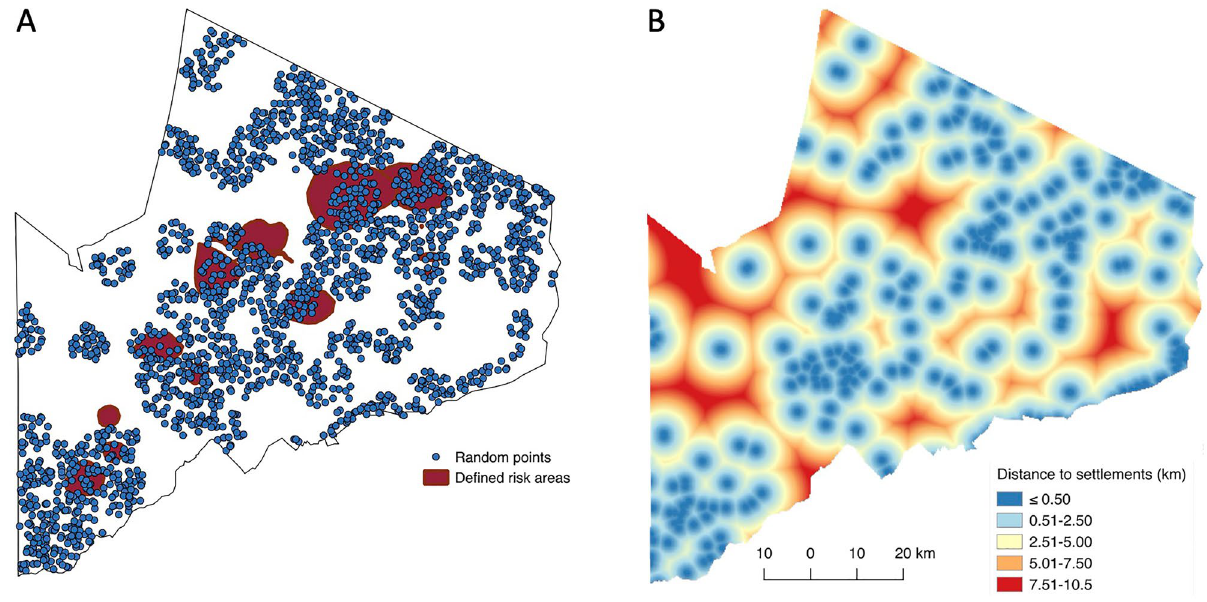
Figure 3. Ngorongoro Conservation Area map showing ( A ) defined risk areas (in red) and ( B ) distance to settlements. For analysis, 5000 random points were generated throughout the area; points falling within 4.26 km of human settlements (the average distance herds are moved from settlements in a day as determined through interviews of resident livestock owners) were retained for analysis (n = 2173, shown in blue in 3a). The maps were created in QGIS 2.18.2 using data from the National Bureau of Statistics, Tanzania (http:// www. nbs. go. of a water source to a risk area may increase the chance of infection, particularly during periods of high precipi- tation which might unearth buried spores. Average enhanced vegetation index (EVI). Vegetation density may influence the likelihood of an animal ingest- ing soil or inhaling dust that may be contaminated with spores. Grazing animals are more likely to encounter bacteria in soil with low vegetation density 20 , although there is a possibility that spores can be washed onto higher vegetation by the action of water 19 . Vegetation index may also reflect the moisture content of soil. Arid/ dry conditions favour the formation and resistance of spores in the environment, thus lower vegetation may be associated with the occurrence of anthrax. Average daytime land surface temperature (LSTD). Anthrax has been more commonly reported to occur in regions with warmer climates worldwide. Minett observed that under generally favourable conditions and at 32 °C to 37 °C, sporulation of B. anthracis occurs readily but vegetative cells are more likely to disintegrate at temperatures below 21 °C 30 . Another hypothesis for the association of high temperature with anthrax occur- rence is altered host immune response to disease due to stress caused by elevated temperatures 19 . In addition, elevated temperatures are usually associated with arid areas where vegetation is low, limiting access to adequate nutrition, which in turn affects immunity. Similarly, in hotter climates where infectious diseases occur more often, host interactions with other pathogens may modulate immune response to anthrax 31 . In this case, a lower infectious and lethal dose of spores would be sufficient to cause infection and death, respectively 19 . Contact with and ingestion of soil, spores and abrasive pasture is also higher with low vegetation in hot and arid areas 19,32 . In boreal regions such as in northern Canada, where anthrax occurs in wood bison, and Siberia, the disease is more commonly reported in the summer 19 . We therefore hypothesised a positive effect of LSTD on the risk of anthrax. Slope. Spores of B. anthracis are hypothesized to persist more easily in flat landscapes that are characterised by shallow slopes 19 , as it is thought that wind and water may disperse spores more easily along areas with a higher slope gradient, thereby decreasing the density of spores to levels that may be insufficient to cause infection in a susceptible host. Therefore, we expected a negative relationship between slope and the risk of anthrax.